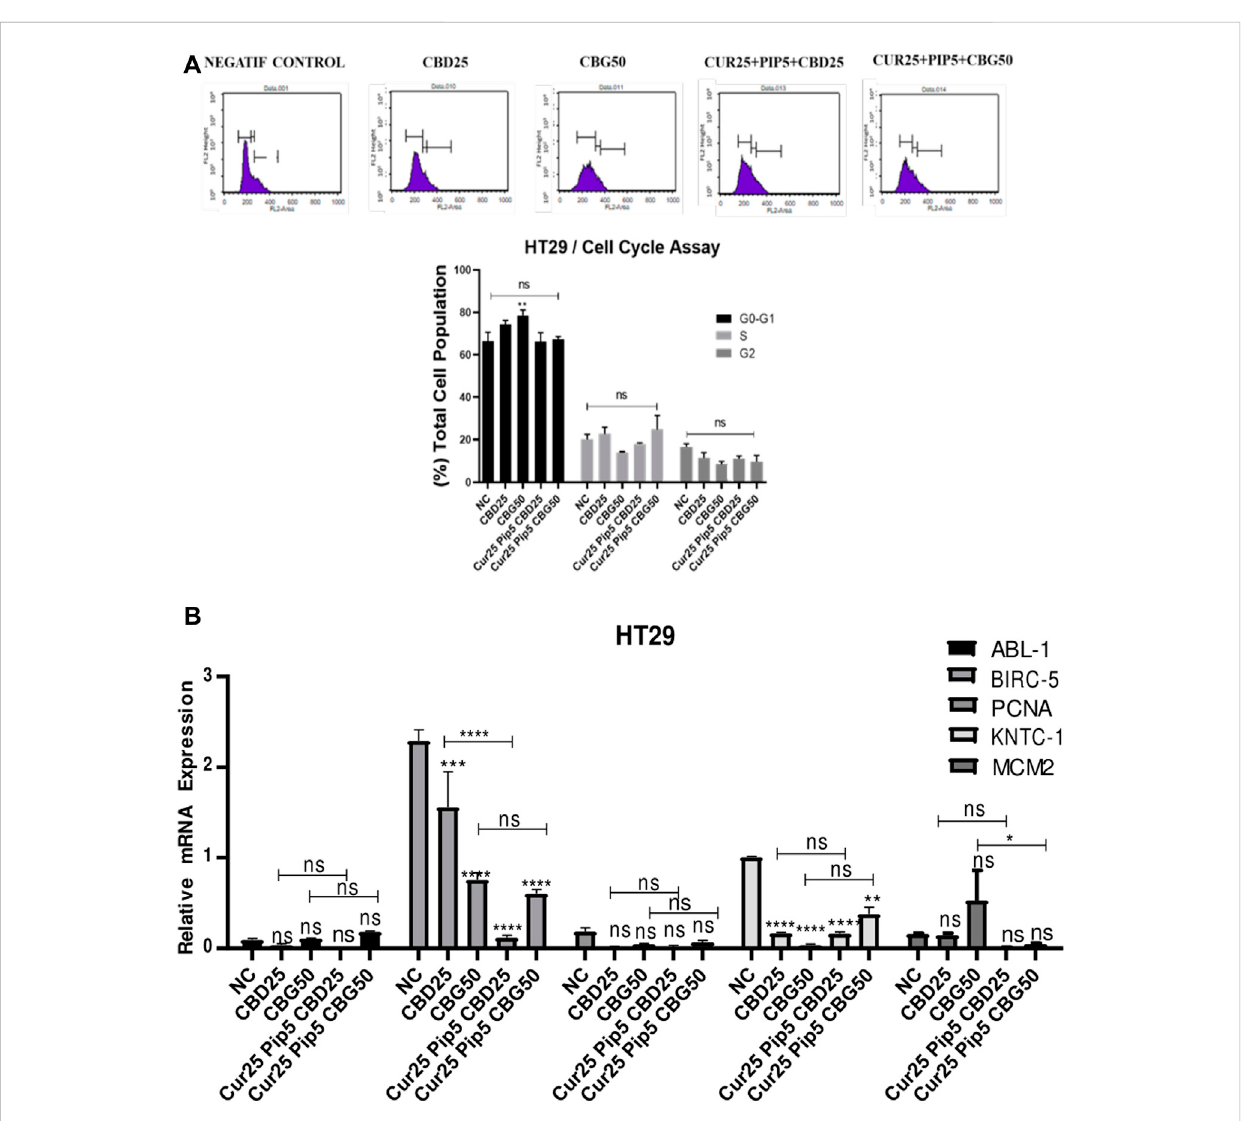
FIGURE 7 Distribution ofcell cycle phasesby fl owcytometryfor HT29 cells (A) Distribution ofcell cycle phases; theinitial, middle, and lastpeaks show G0/G1, S and G2 respectively and the result of cell cycle analysis percentage of HT29 cells in G0/G1, S and G2 phase compared with negative control. (B) Representative graph of cell cycle genes expression pro fi les of HT29 cells after 72 h. (ns: non-signi fi cant, *: p < 0.05, **: p < 0.01, ***: p < 0.001, ****: p <